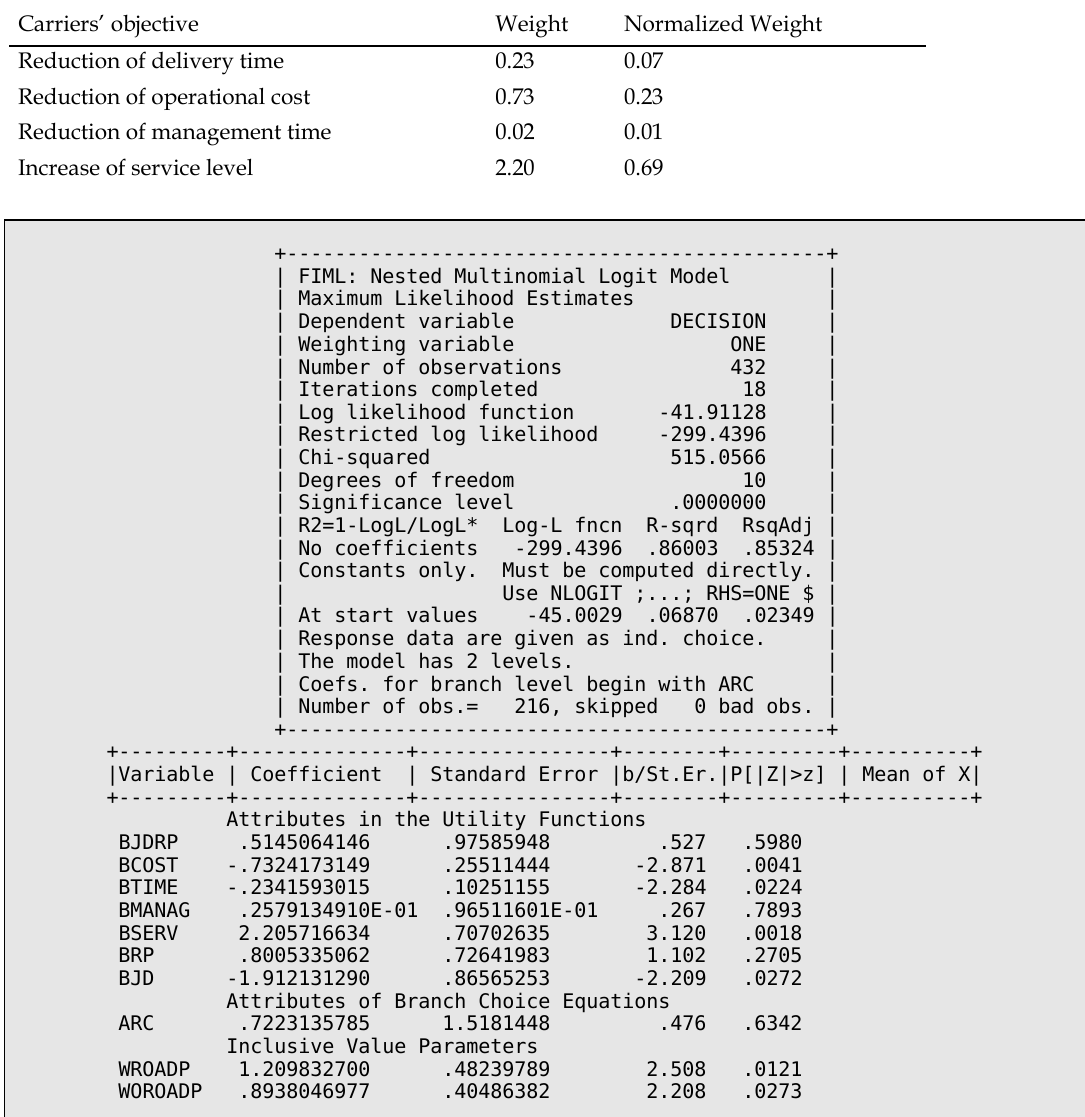
Table 9. Weights obtained for the carriers’ objectives in the hierarchical discrete choice analysis